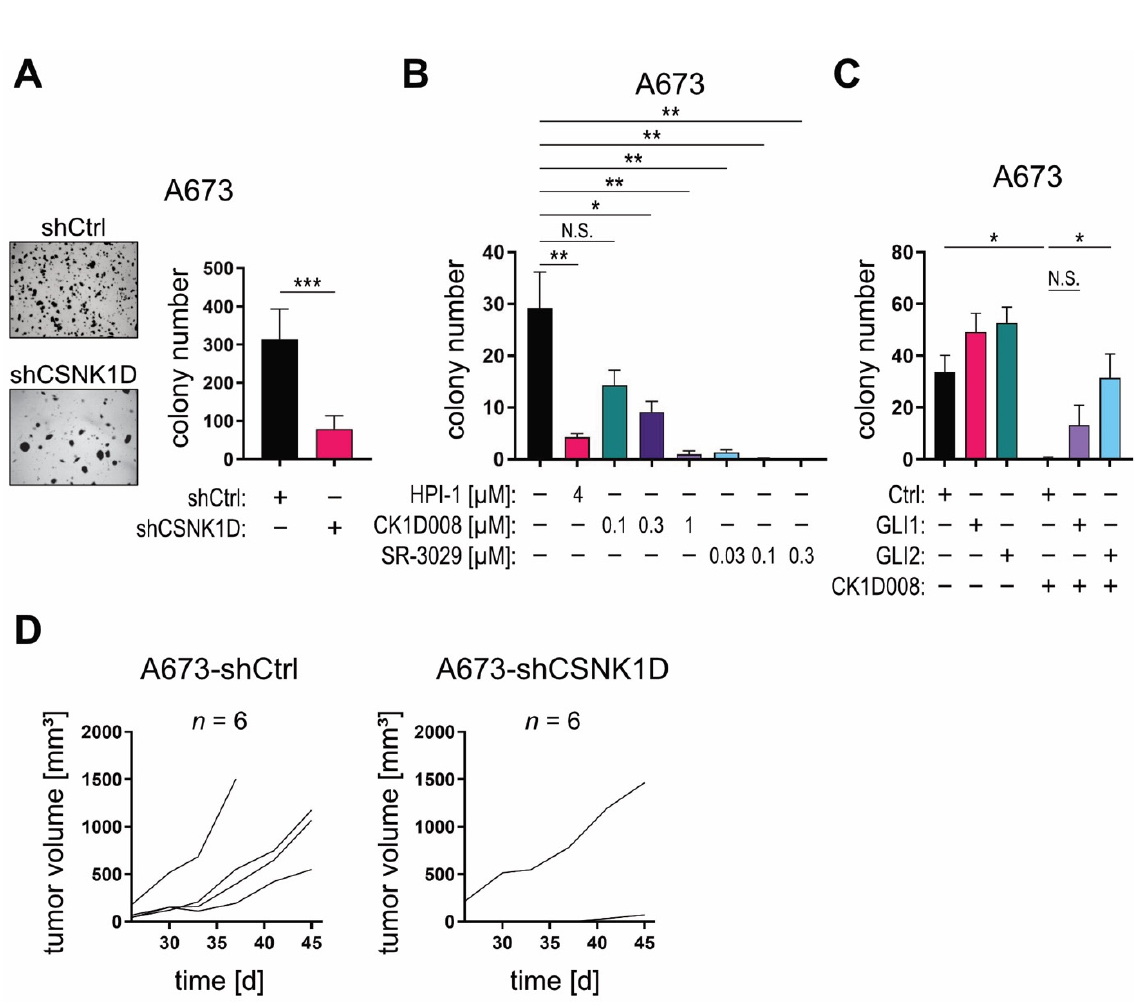
Figure 5. Targeting CSNK1D reduces GLI-dependent 3D tumor spheroid formation in vitro as well as tumor engraftment in vivo. ( A ) A673 cells were lentivirally transduced with shCSNK1D or control shRNA (shCtrl) and cultured under anchorage-independent conditions. Representative images of formed 3D spheroid colonies (left panel). The number of 3D spheroid colonies was counted (right panel) ( n = 8). ( B ) A673 cells were cultured under anchorage-independent conditions and treated with the GLI inhibitor HPI-1 [4 µM], CK1D008 [0.1–1 µM] or SR-3029 [0.03–0.3 µM]. The data represent the mean of six 3D culture experiments. ( C ) A673 cells were retrovirally transduced with GLI1 , active GLI2 (GLI2act) or control overexpression constructs, cultured under anchorage-independent conditions and treated with CK1D008 at non-toxic concentration [0.3 µM]. The number of 3D spheroid colonies was counted ( n = 4 experiments). ( D ) A673 cells were lentivirally transduced with shCSNK1D or control shRNA (shCtrl) and engrafted in the flanks of NSG mice ( n = 6 mice each). Tumor volume was measured every 3–4 days. Student’s t test was used for statistical analysis (* p < 0.05; ** p < 0.01; *** p < 0.001).